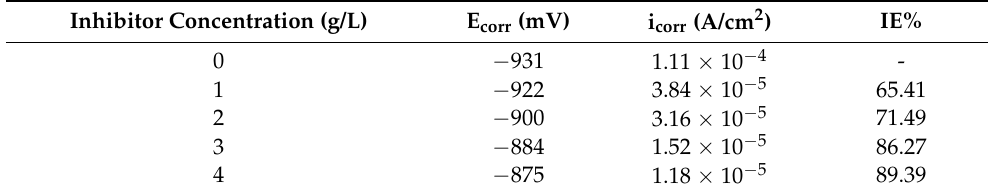
Table 1. Analysis results of potentiodynamic polarization curves of carbon steel electrodes in different concentrations of corrosion inhibitor solutions.